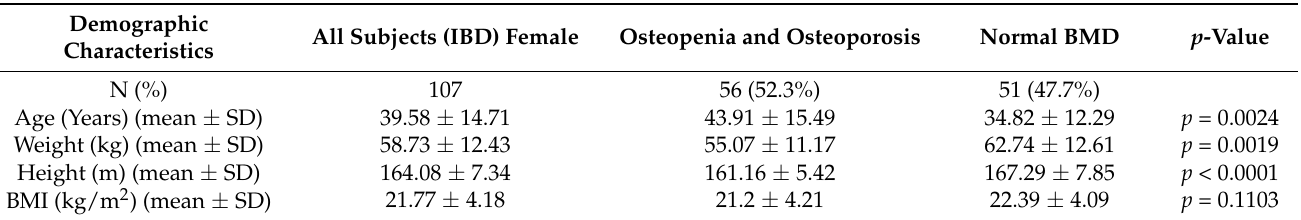
Table 4. The demographic and anthropometric parameters of the studied female IBD patients with respect to osteoporosis and osteopenia.